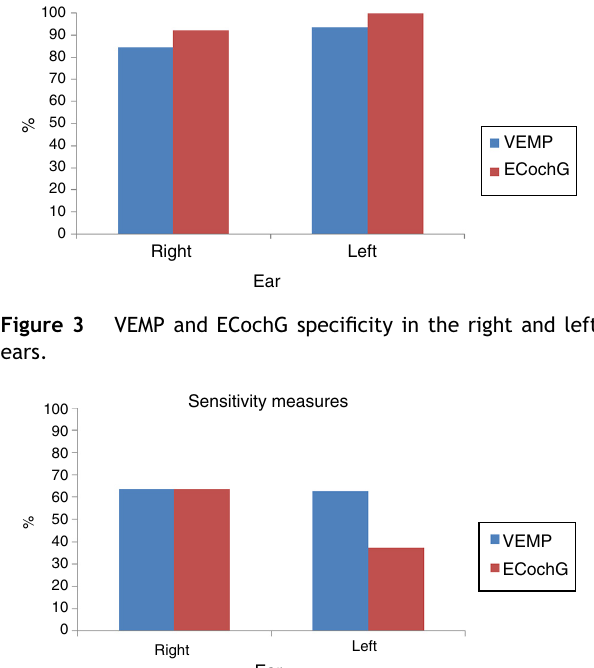
Figure 4 VEMP and ECochG sensitivity in the right and left